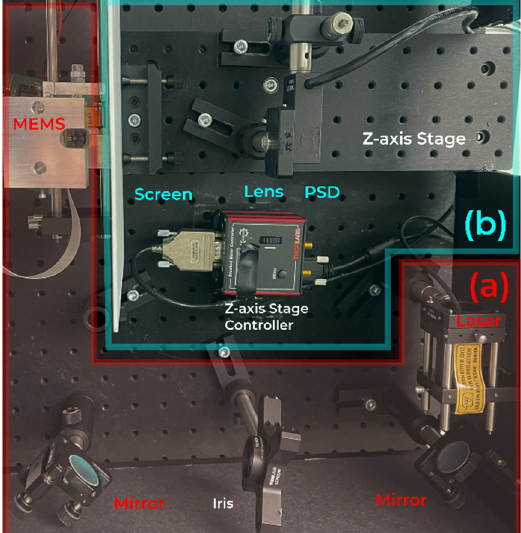
Figure 6. Picture of the main configuration of the setup to characterize a MEMS scanner. The overlay shows the used components in the laser part ( a ) and the detection part ( b ).